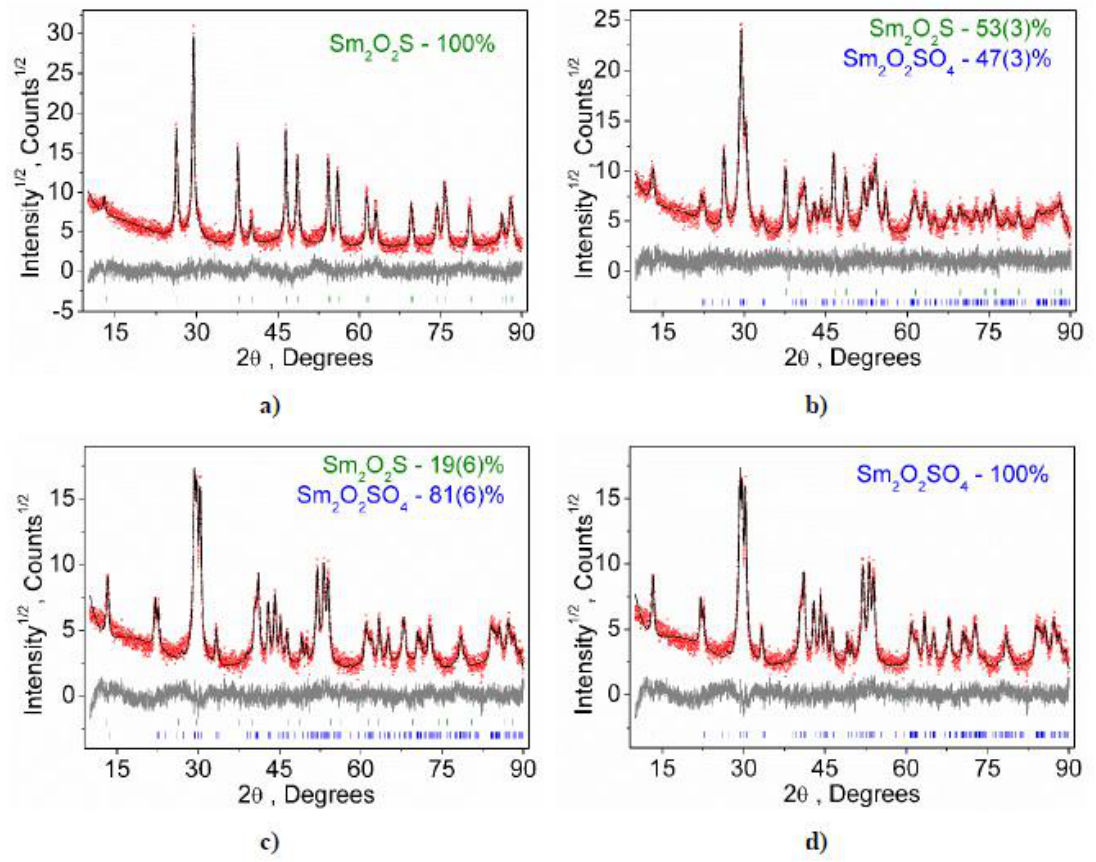
Figure 2. X-ray diffraction patterns of Sm 2 O 2 S ( a ) and the samples subjected to oxidation at 600 °C for 2 h ( b ), 5 h ( c ) and 7 h ( d ).